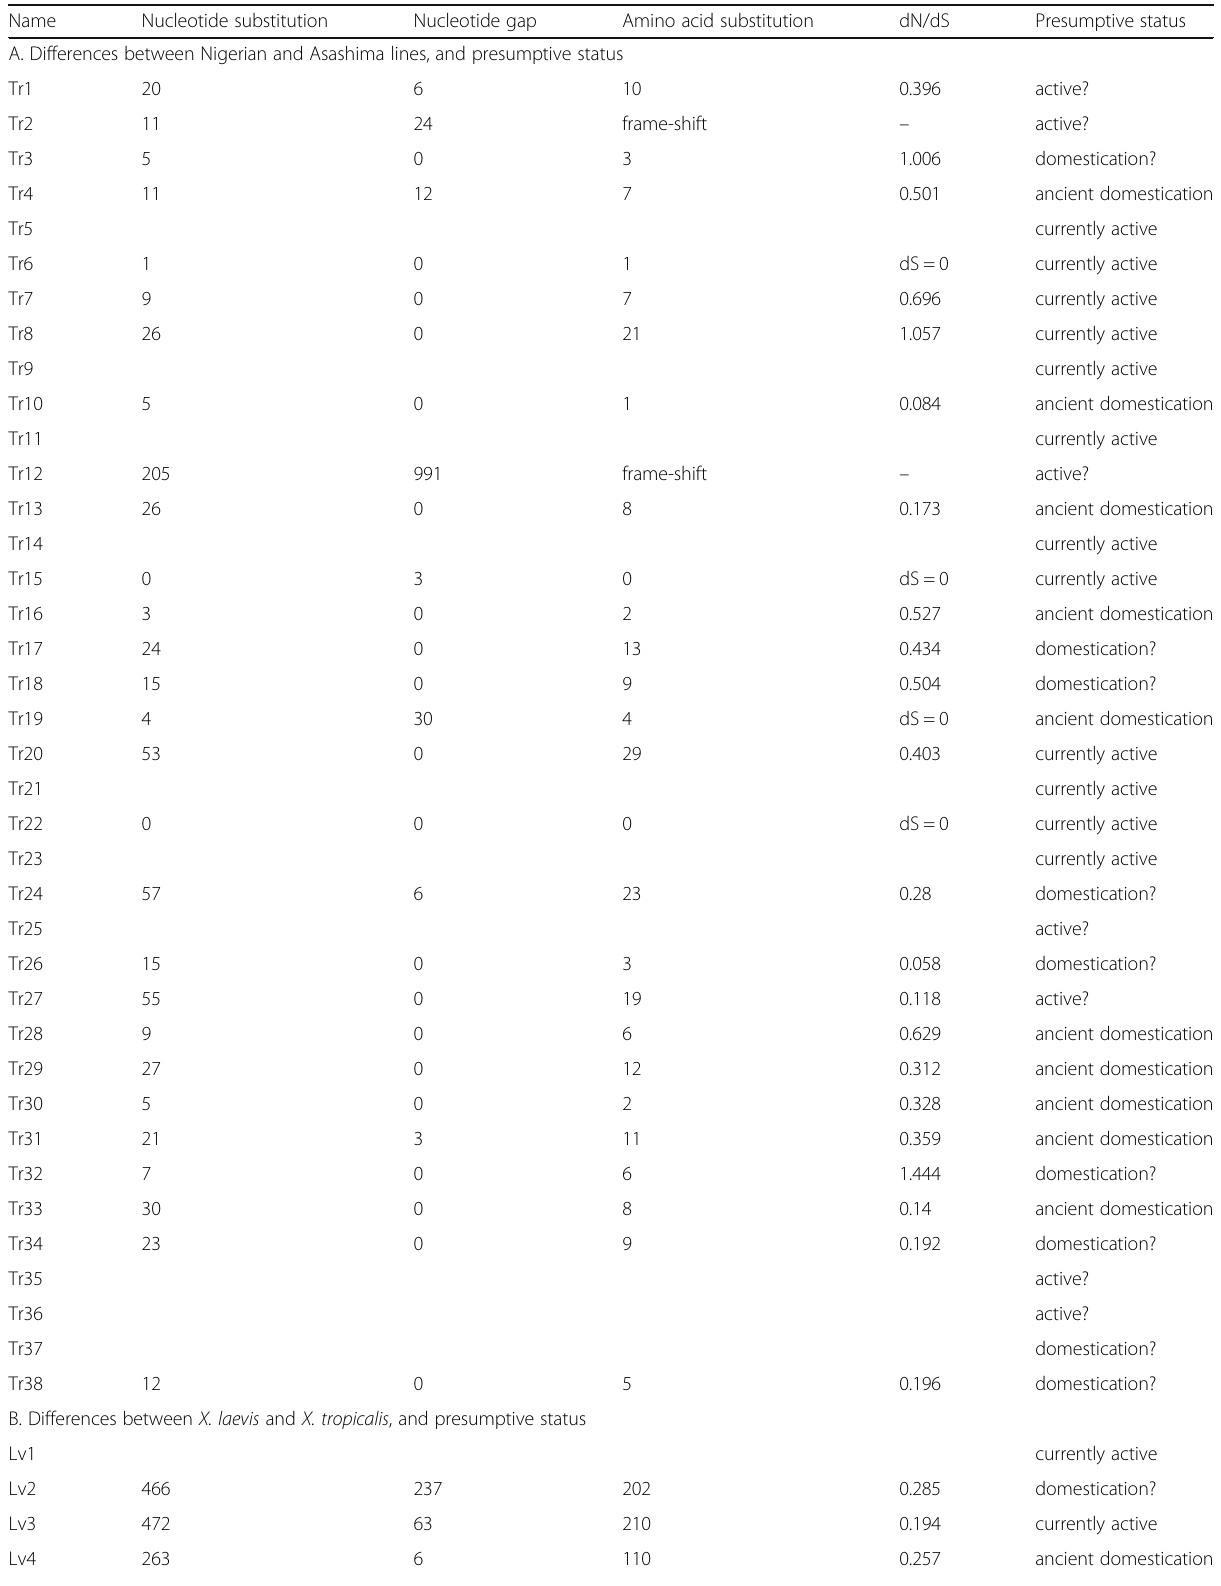
Table 4 Differences in transposase CDSs and amino acids, and presumptive